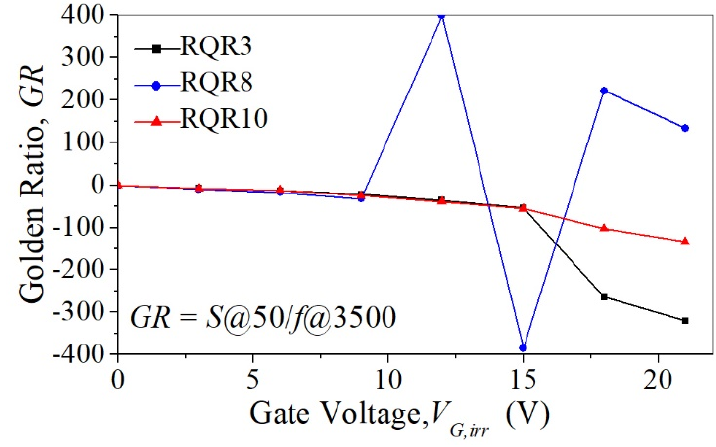
Figure 11. ∆ N st at K air = 50 Gy versus gate voltage during irradiation.